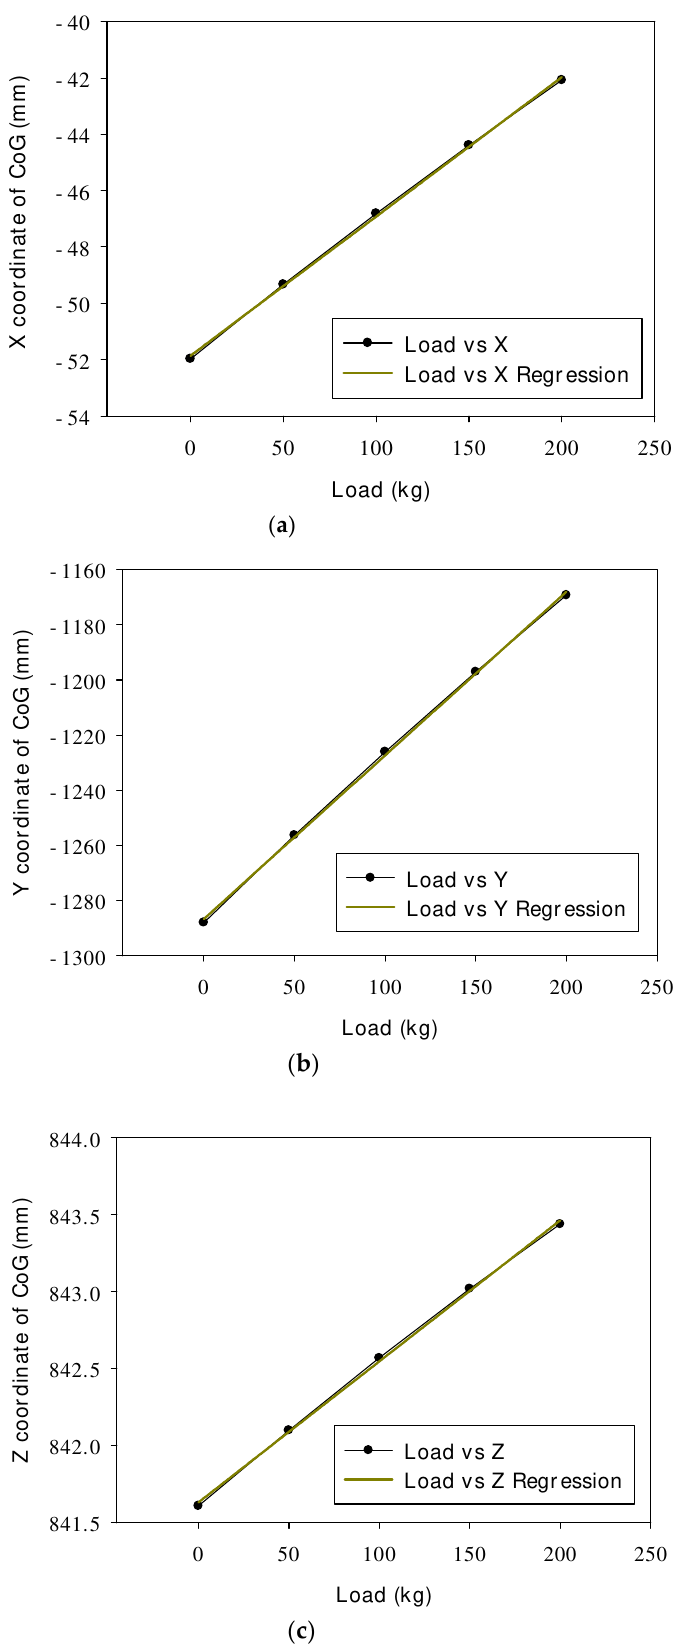
Figure 5. CoG deformations of pepper harvester with loading conditions ( a ) X coordinate, ( b ) Y coordinate, ( c ) Z